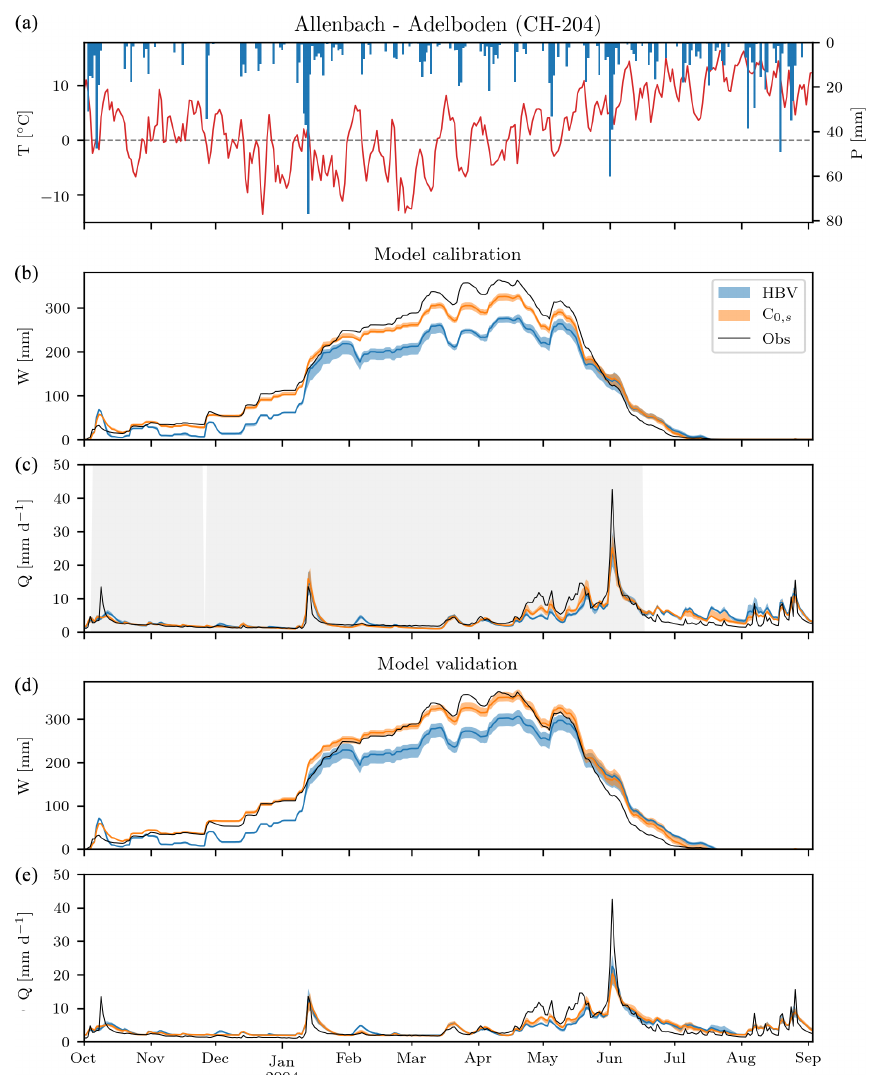
Figure 4. Example time series (October 2003–September 2004) from the Allenbach catchment at Adelboden (CH-204). (a) Daily mean air temperature and total precipitation. (b, c) Model calibration results for period 1. (d, e) Model validation results (based on model calibration on period 2). The model calibration and validation are further subdivided into (a) catchment-average observed (grey line) and simulated snow water equivalent (HBV in blue and the model structure modification including a seasonally varying degree-day factor, C 0 , s , in orange) and (d, e) observed (grey line) and simulated stream runoff (HBV in blue and the model structure modification including a seasonal degree-day factor in orange). The grey field represents the period used when calibrating the model against the logarithmic stream runoff. The uncertainty fields for model simulation cover the 10th–90th percentile range, while the solid line represents the median